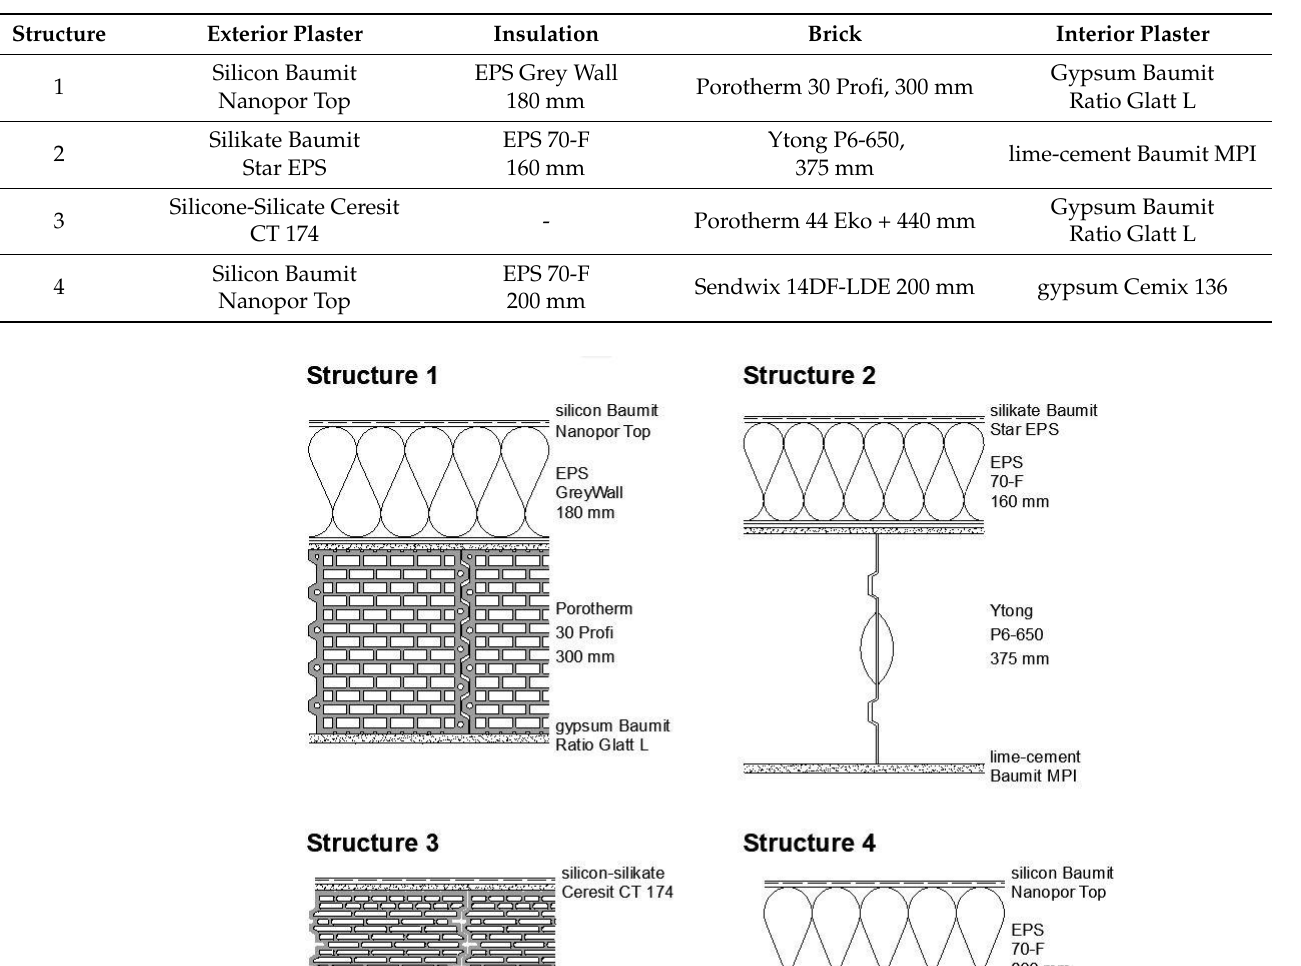
Table 2. Structures of four random external walls.